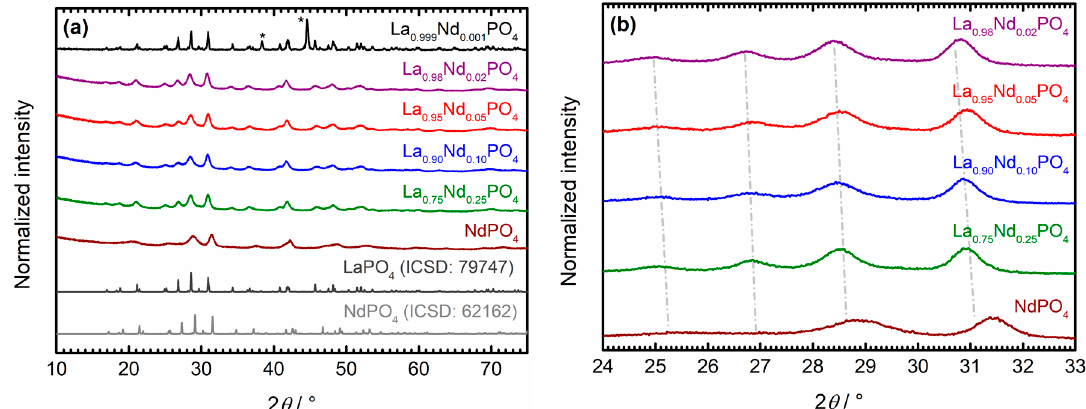
Figure 1. ( a ) X-ray powder diffraction (XRPD) patterns of synthesized microcrystalline La 0.999 Nd 0.001 PO 4 and La 1- x Nd x PO 4 nanocrystals in comparison to the diffraction patterns of LaPO